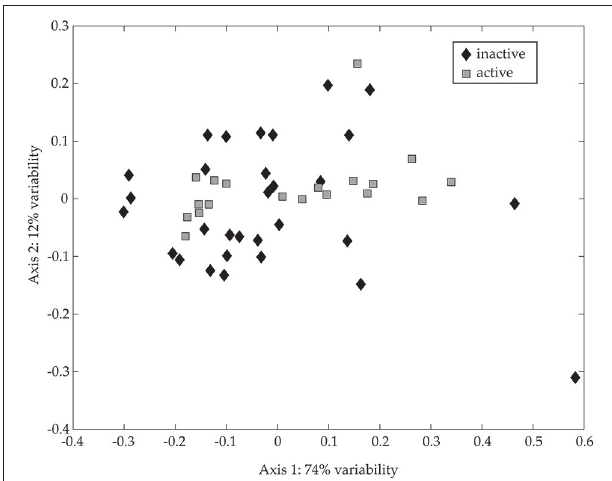
FIGURE 9 | NMS ordination of 18S rDNA CsCl TRFLP samples. NMS ordinations were calculated as described in the text based on TRFLP patterns for appropriate samples. The TRFs occurring in the 13 C-enriched (“active”; gray squares) and the non-enriched (“inactive”; black diamonds) regions of the CsCl gradient are presented. The stress for this ordination is 0.159 and the r 2 between the original distance matrix and this NMS ordination is 0.85. The degree of variability represented by each axis was calculated using a Mantel test (see text) and is presented in the axis